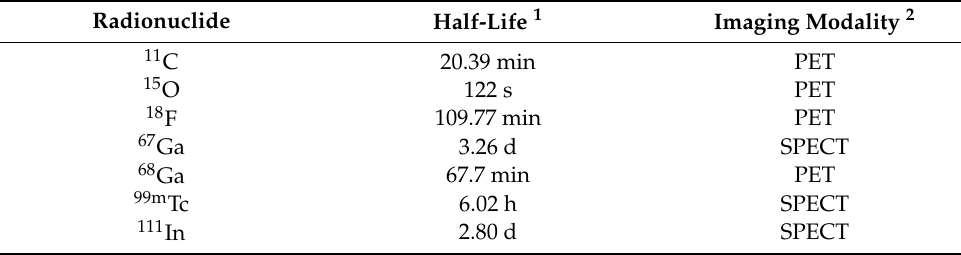
Table 1. An overview of radionuclides and their half-lives. Radionuclide Half-Life